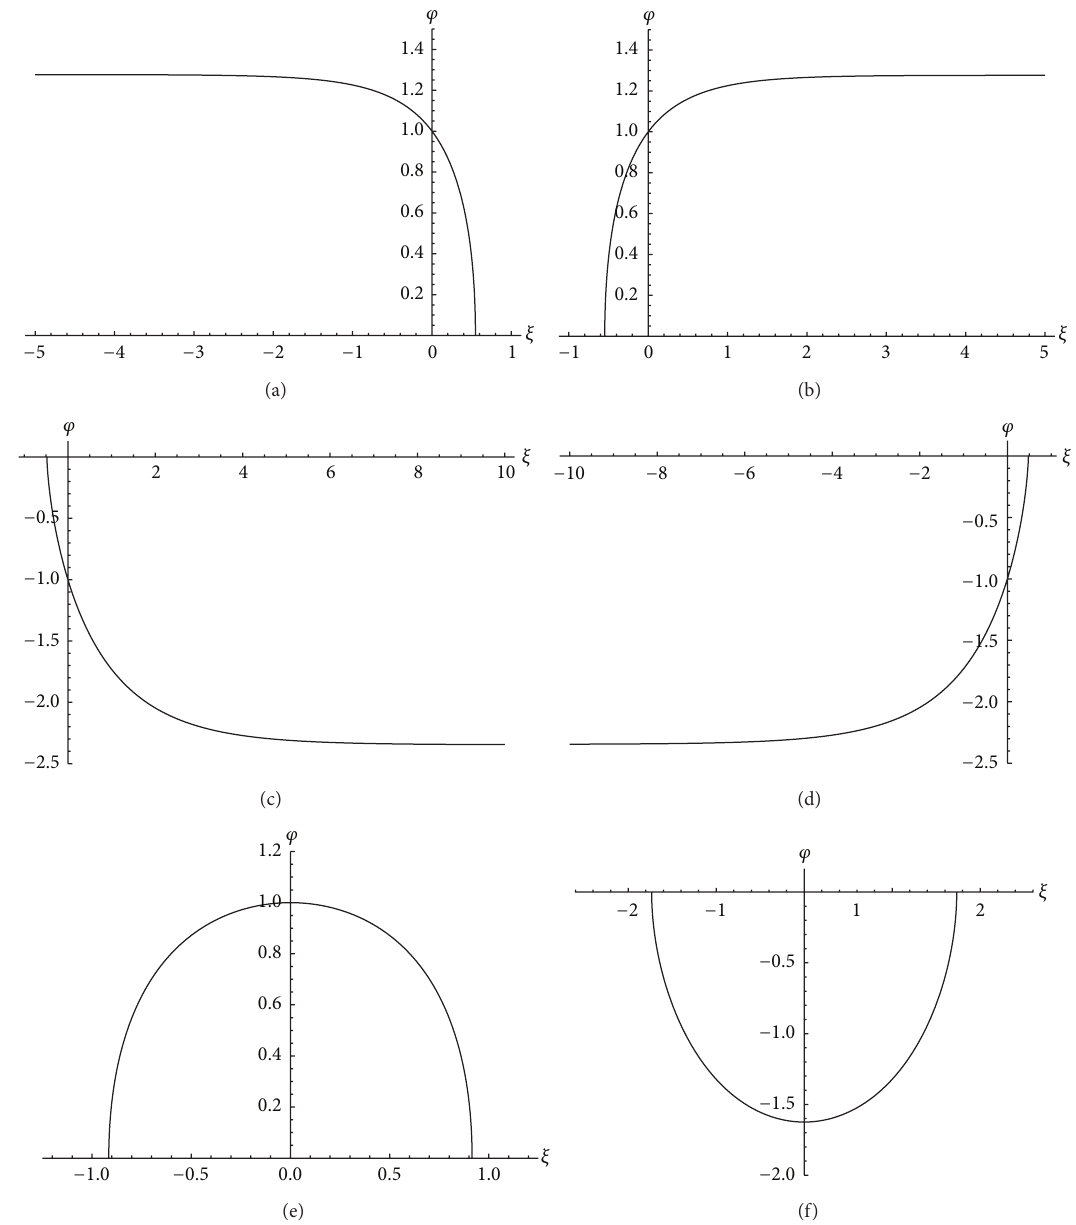
Figure 2: The simulations of integral curves of (8) when 𝜃 = −1 , 𝑔 = −1.39361 (corresponding to Example 1), and 𝑔 = −0.696804 (corre- sponding to Example 2). (a) 𝜑(0) = 1 and 𝜑 󸀠 (0) = −0.5160826789900144 . (b) 𝜑(0) = 1 and 𝜑 󸀠 (0) = 0.5160826789900144 . (c) 𝜑(0) = −1 and 𝜑 󸀠 (0) = −1.1707040231039854 . (d) 𝜑(0) = −1 and 𝜑 󸀠 (0) = 1.1707040231039854 . (e) 𝜑(0) = 1 and 𝜑 󸀠 (0) = 0 . (f) 𝜑(0) = −1.624378546433569 and 𝜑 󸀠 (0) = 0